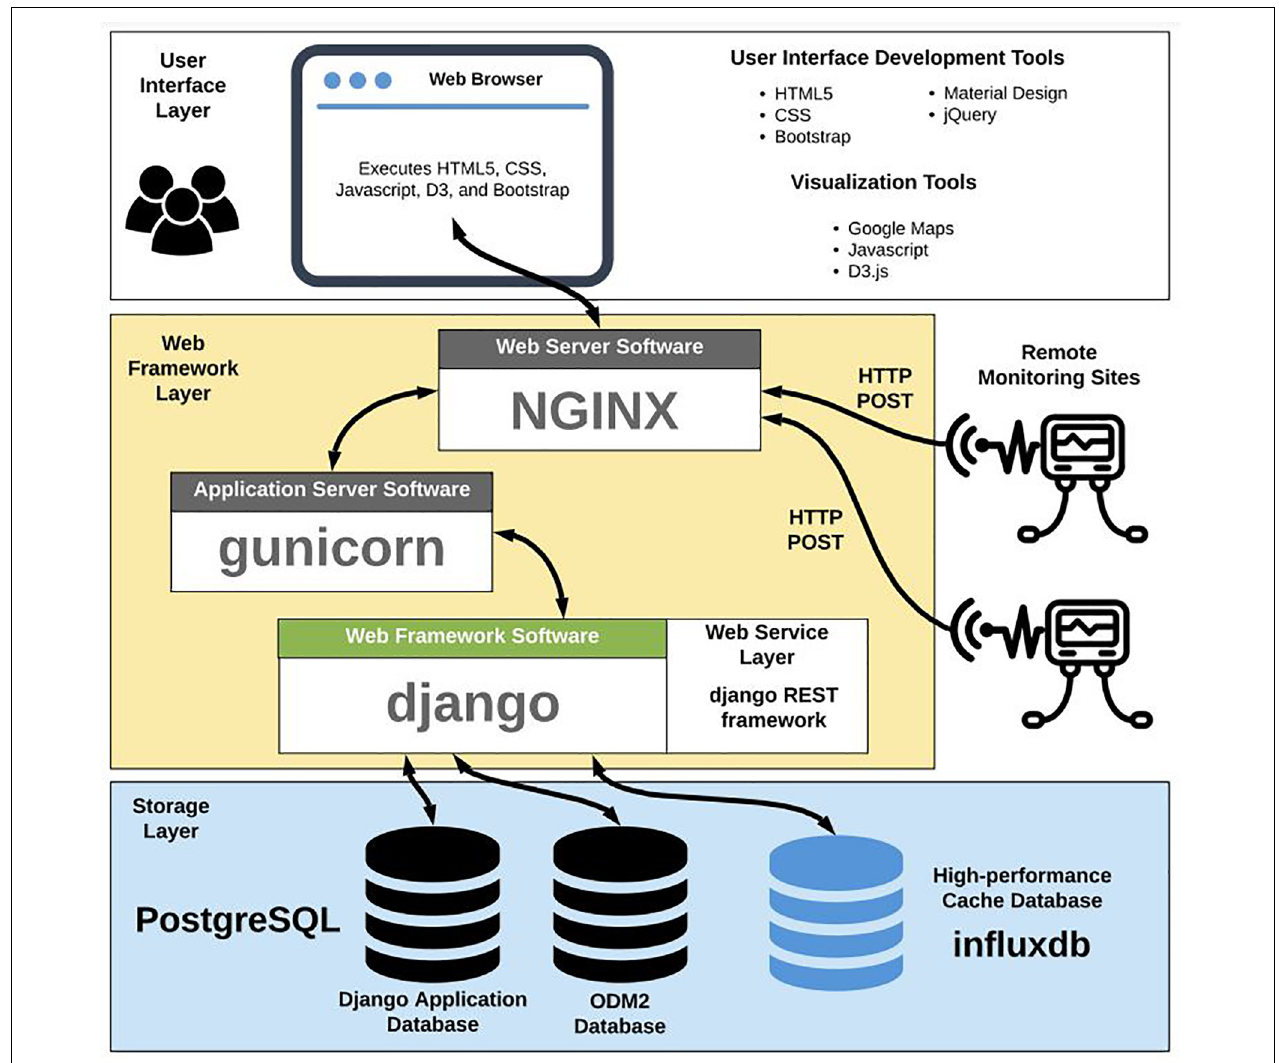
FIGURE 1 | Architecture of the Data Sharing